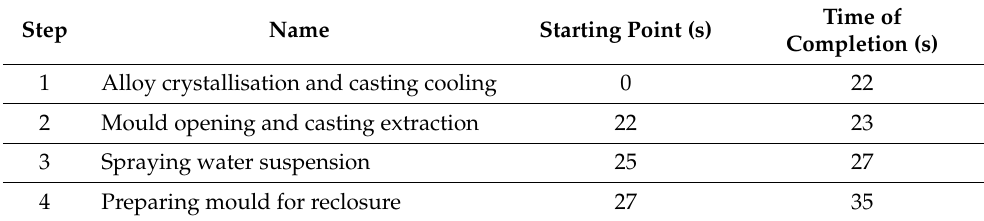
Table 2. HPDC cycle stages adopted in the thermal